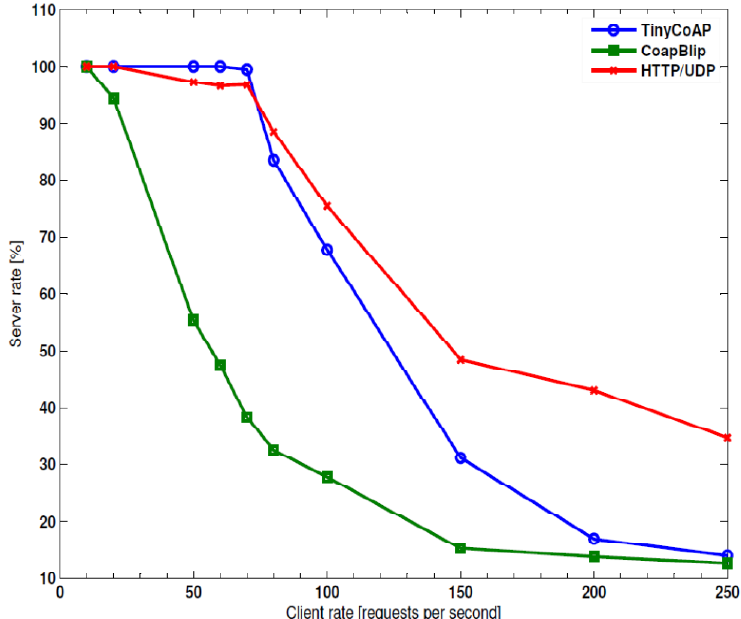
Figure 9. Number of requests handled by the server as a function of the client rate. The enhanced buffers of TinyCoAP allows to that to overcome the CoapBlip